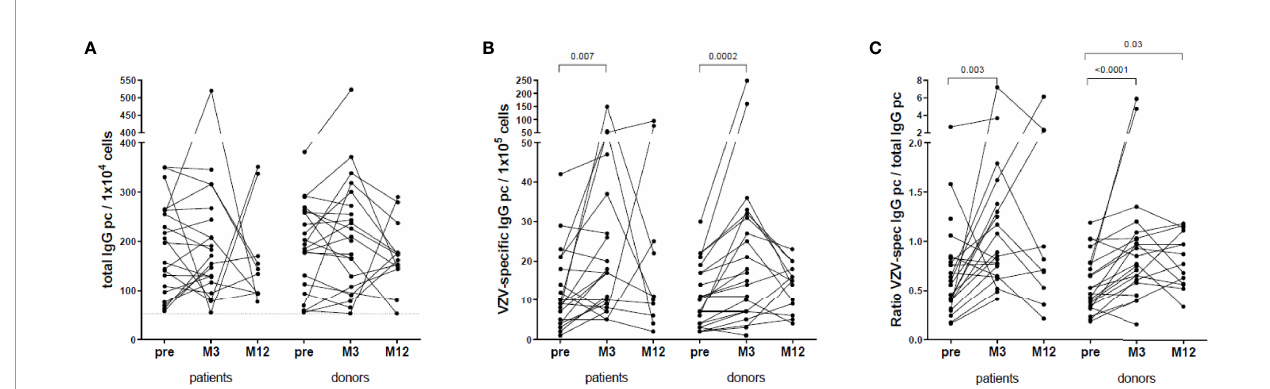
FIGURE 4 | VZV-speci fi c B cell response. (A) Total IgG producing B cells per 10 4 cells. (B) VZV-speci fi c IgG producing B cells per 10 5 cells. (C) Ratio between VZV-speci fi c IgG producing B cells and total IgG producing